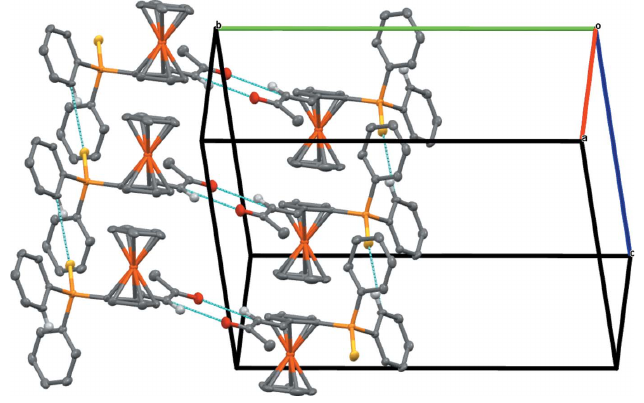
(8) pseudo-ring 2